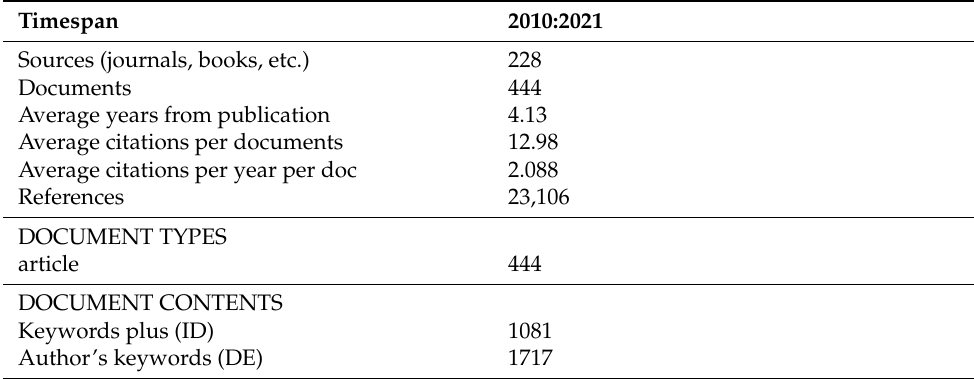
Table 3. Main information about data